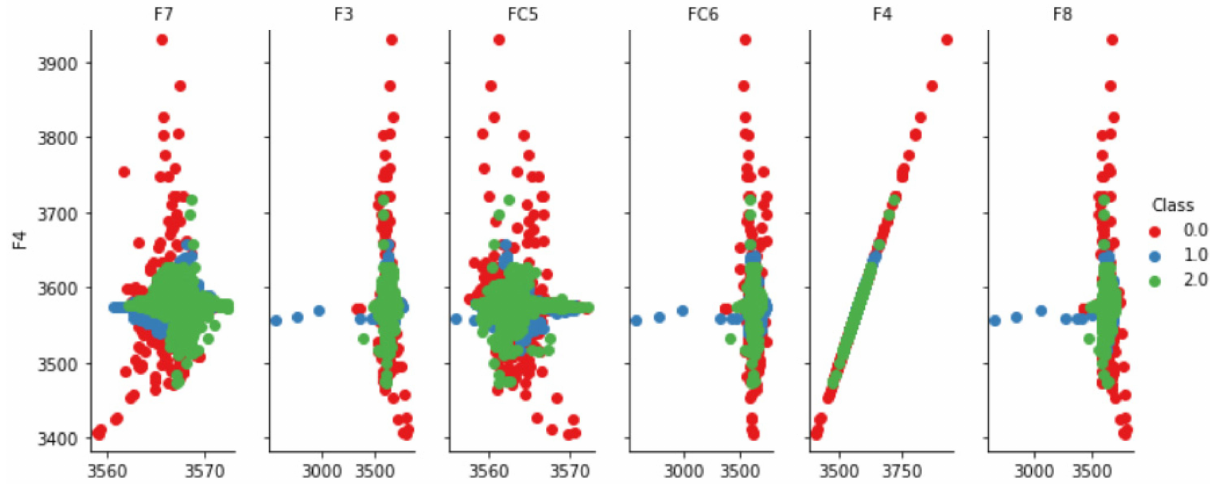
Figure 10. F4-Electrode correlation with each electrode and they are scattered plots based on la- belled classes.